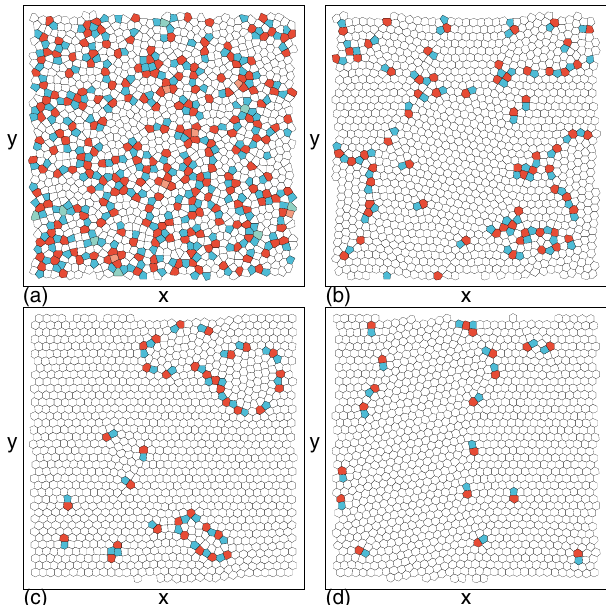
Fig. 4 Final ordering of lattice at different quenching speeds. Voronoi plots of the fi nal driving force F D = 1.5 state for the system in Fig. 3a, b with vortex density n v = 1.0, pinning density n p = 0.5, pinning force F p = 0.4, and pinning radius r p = 0.3 at quench times of ( a ) t q = 7.5 × 10 3 , ( b ) 3 × 10 4 , ( c ) 7.5 × 10 4 , and ( d ) 3 × 10 5 . The number of defects is larger for smaller t q or a faster sweep rate.